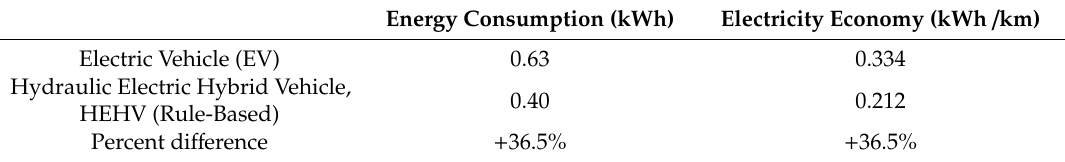
Figure 11. Battery SOC comparison of EV and HEHV.